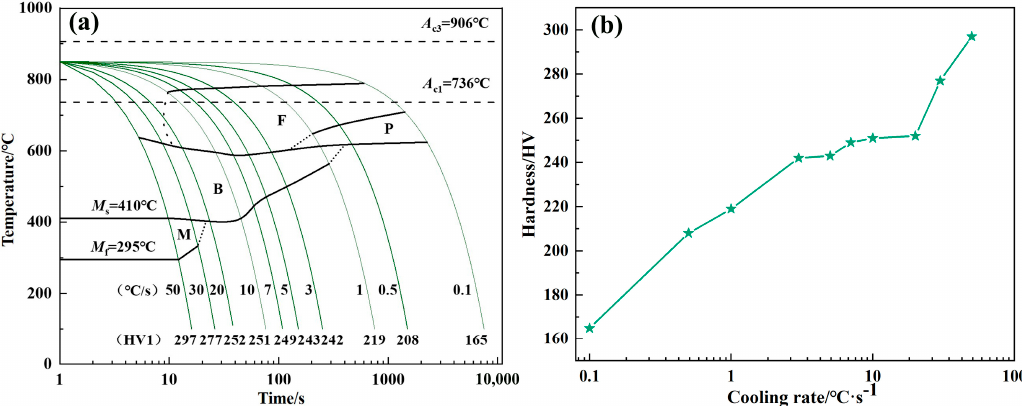
Figure 3. ( a ) Dynamic CCT curve of test steel; ( b ) hardness of di ff erent cooling rates of test steel.